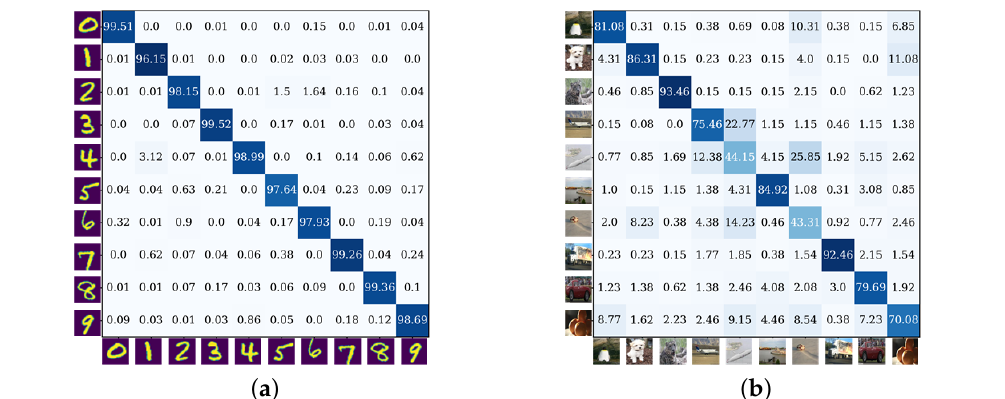
Figure 2. Confusion matrixes of the cluster results. ( a , b ) represent the clustering results on MNIST and Imagenet10 datasets, respectively.